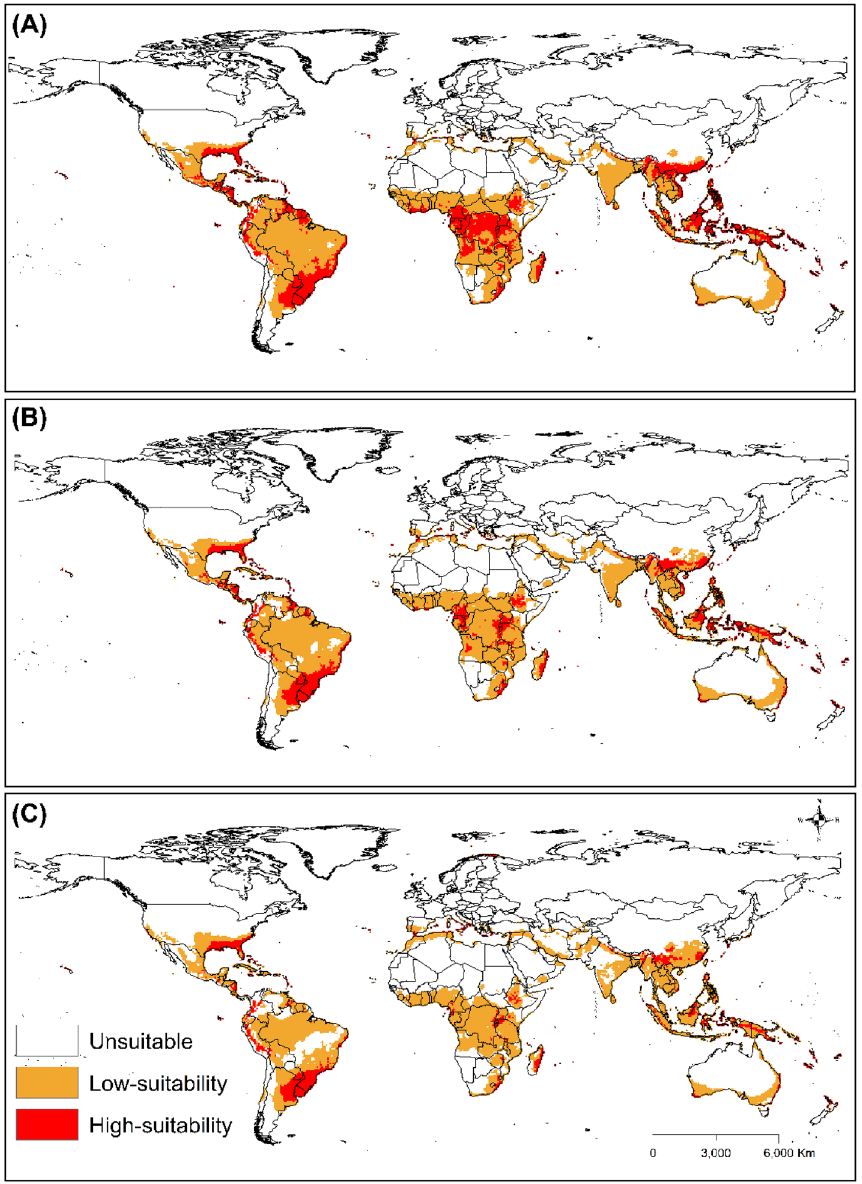
Figure 6. The Ecoclimatic Index (EI) for T. radiata modelled using the CLIMEX model in the CSIRO-Mk3.0 GCM running the SRES A2 scenario for 2050 ( A ), 2070 ( B ), and 2090 ( C ). ESRI ArcMap 10.2.2 (https:// suppo rt. esri. com/ en/ Produ cts/ Deskt op/ arcgis- deskt op/ arcmap/ 10-2- 2# downl oads) and CLIMEX 4.0.0 (https:// www. hearne. softw are/ Softw are/ CLIMEX- DYMEX/ Editi